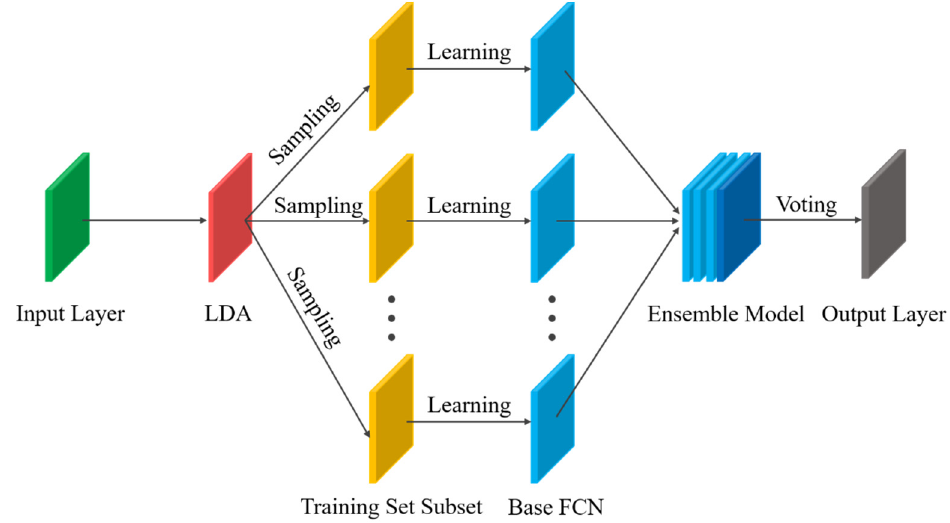
Figure 18. TS-OVPE network structure. The network uses a parallel integrated learning method. After dimensionality reduction processing by linear discriminant analysis, the sub-training set is built by bootstrap sampling. The base learners are established for parallel training, and the final prediction is performed by voting.